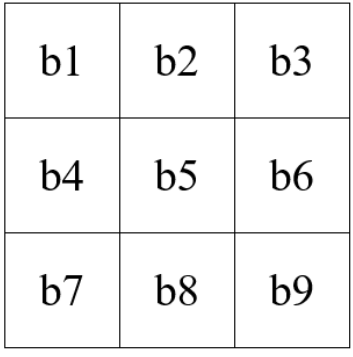
Figure 1. Structural element b.